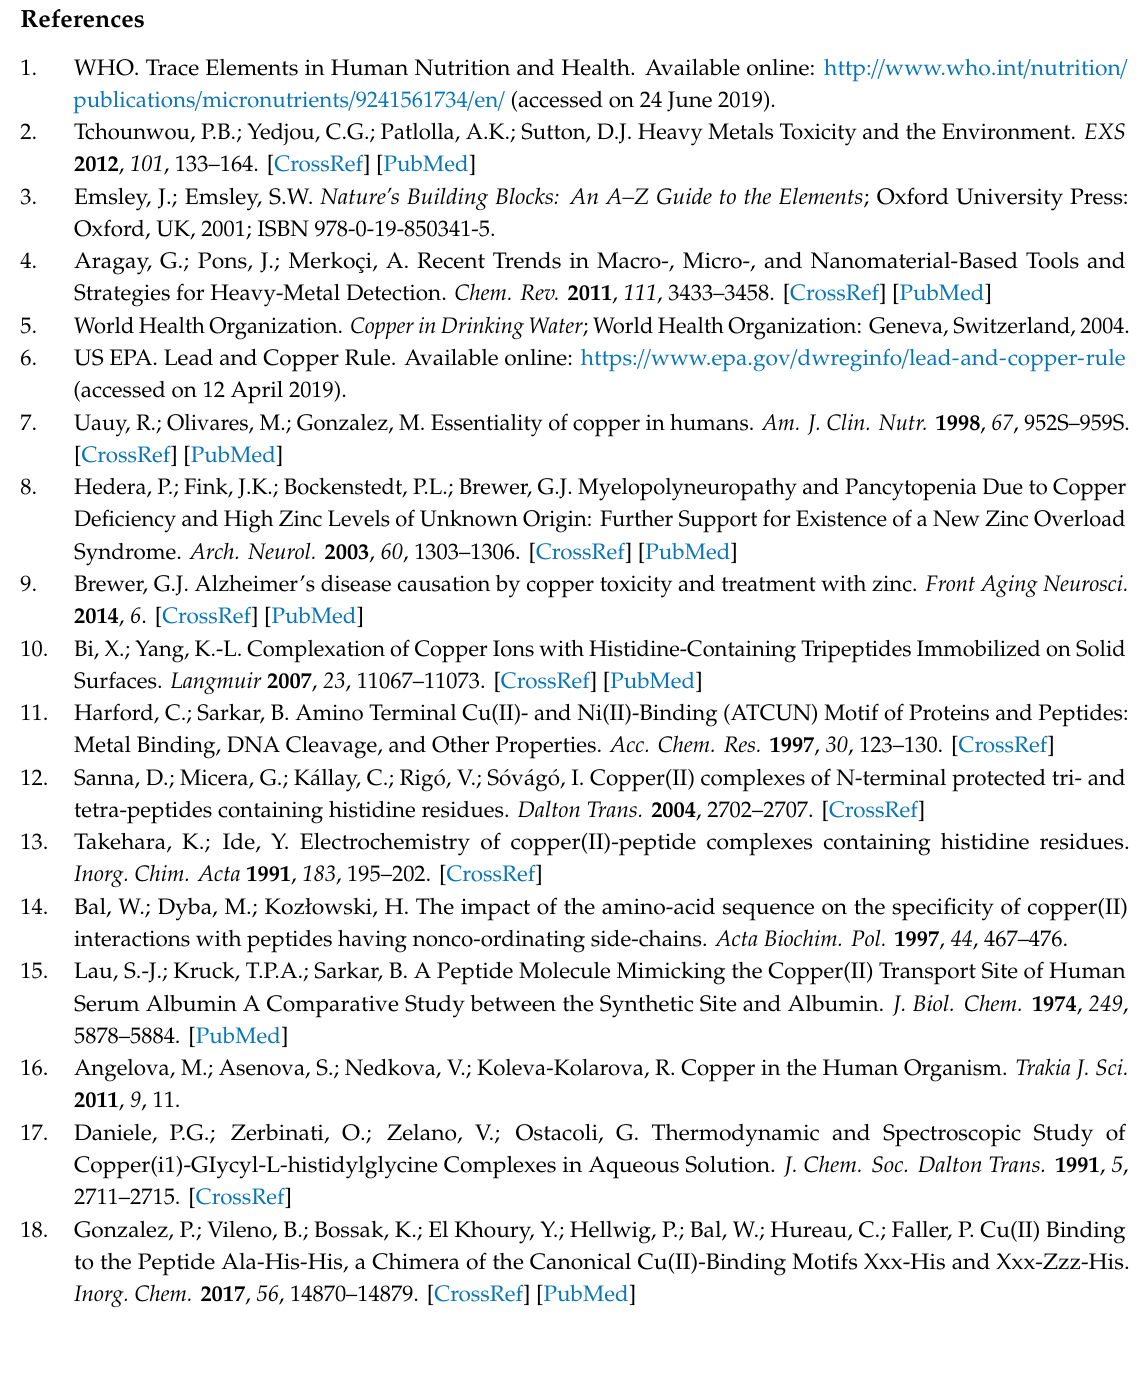
4022 / s1, Figure S1: ISFET Device Structure, Figure S2: Chelation Reactions, Figure S3: Control Measurements at Low Concentration and Low pH, Figure S4: pH Dependence of Copper Ionic